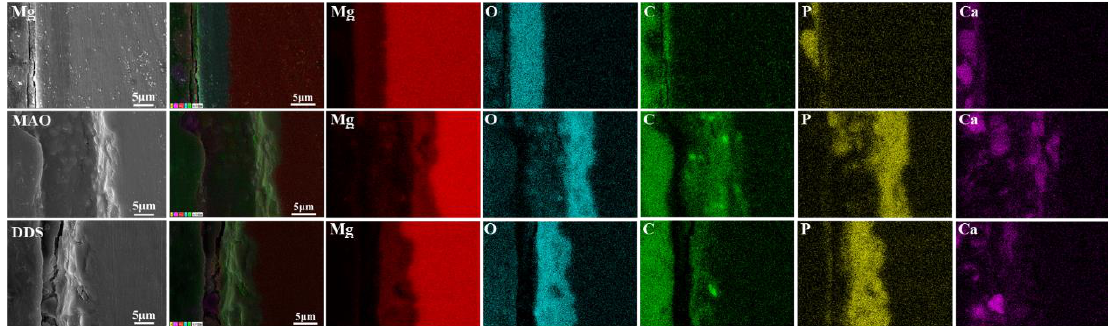
Figure 6. The cross-section images of Mg alloy, Mg-based MAO alloy, and Mg-based MAO-MT-PLGA DDS after immersion in Hank’s solution for 28 days.